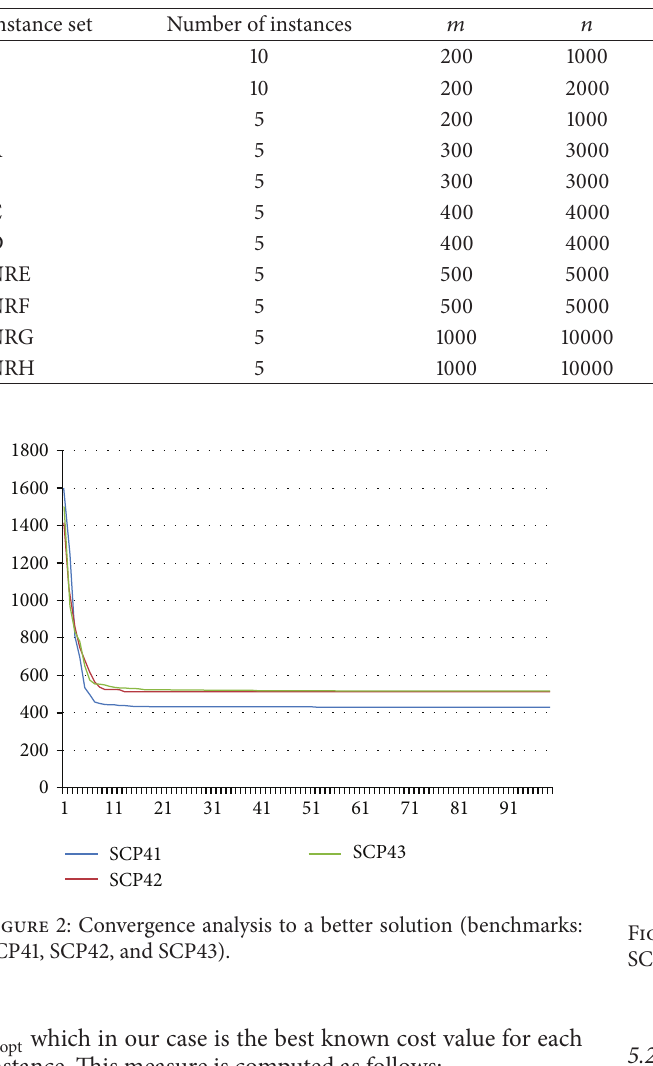
Table 3: Details of the 65 test instances.